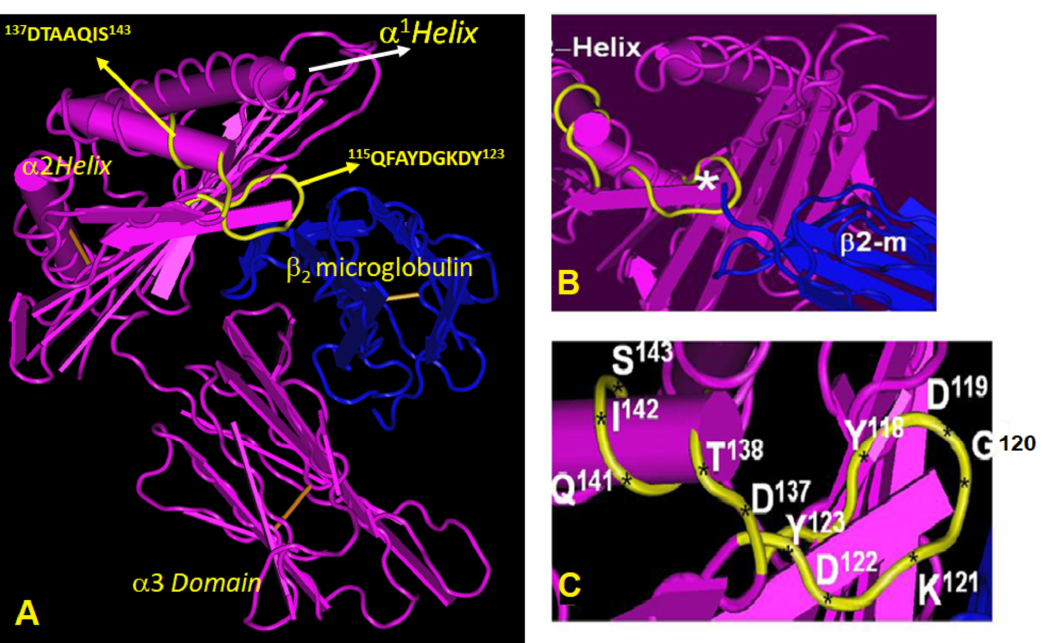
Figure 4. ( A ) The conformational orientation of HLA-E clarifying the location of TFL-006/TFL-007 binding domain (in yellow) in all HLA class I molecule. ( B ) Figure illustrates the steric hinderence caused by β2-microglobulin (blue); therefore 117 AYDGKDY 123 , is a cryptic epitope not accessible in intact HLA molecules (closed conformers); ( C ) Figure illustrates exposure of 17 AYDGKDY 123 on β2-m-free heavy chains of HLA (open conformers). Since HLA-E mAbs may recognize non-linear sequences, it is possible that the anti- HLA-E mAbs recognize unique conformations of the shared amino acid sequences of B*4006 (Figure 5). In support of this suggestion, Figure 6 illustrates the proportional vari- ations in the MFI of the mAbs reacting to HLA-E and B*4006. The ten mAbs in subgroup A of Group R-IV reveal binding affinity for B*4006 and C*1802. Similarly, six mAbs in subgroup B of the Group R-IV show affinity for C*0501 in addition to recognizing B*4006 and C*1802. The 14 mAbs in subgroups C, D, and E show expanded affinity for other alleles of HLA-B and HLA-C isoforms in addition to the stronger binding affinity for B*4006 and C*1802.